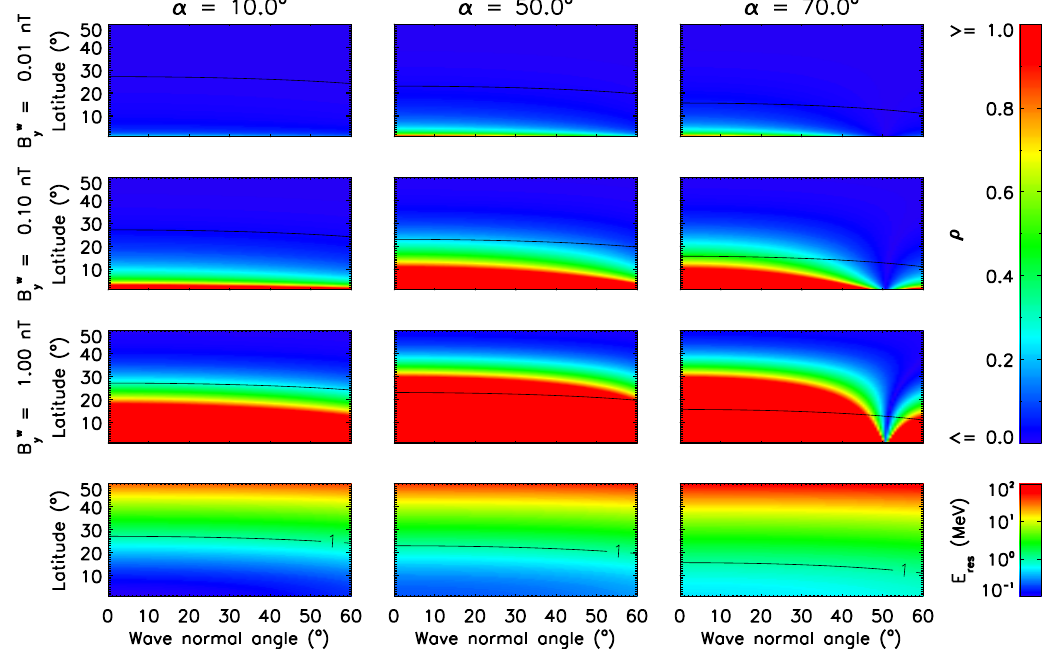
Fig. 2. The nonlinear parameter χ plotted as a function of latitude and wave normal angle for a whistler wave with ω = 0 . 1 (cid:127) ce0 at selected pitch angles, with effects of time rate change of k k ignored. Here (cid:127) ce0 is the electron angular gyrofrequency at the equatorial plane. The first three rows correspond to different wave amplitudes: B w y = 0 . 01nT (first row), 0.1nT (second row), and 1.0nT (third row). Different columns correspond to different local pitch angles: α = 10 . 0 ◦ (left), 50.0 ◦ (middle), and 70.0 ◦ (right). All black lines show the location of E res = 1MeV. The fourth row shows the electron resonant energy in MeV.